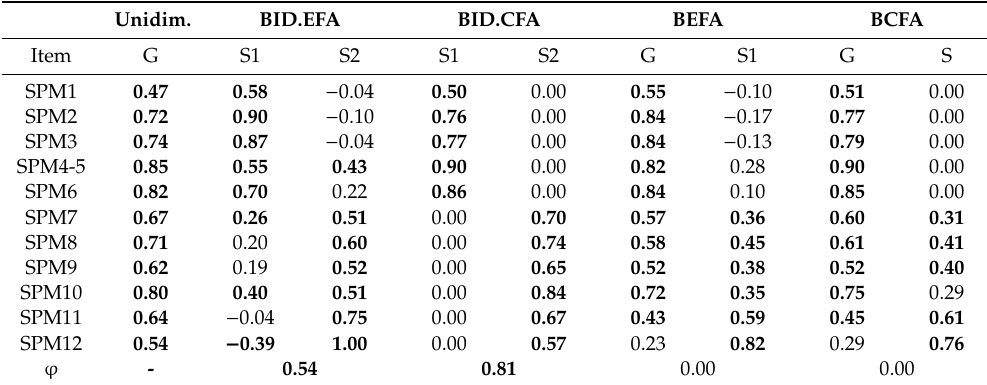
Figure A2. Exploratory Graph Analysis of SPM-LS data with SPM4 and SPM5 item combined. Dimensions and items associated are presented in different colours. Positive partial correlations are depicted in green, with negative partial correlations presented in red. The size of the lines indicates the size of the partial correlations. SPM4 = SPM4-5 item. Table A2. Standardised factor loadings for all model